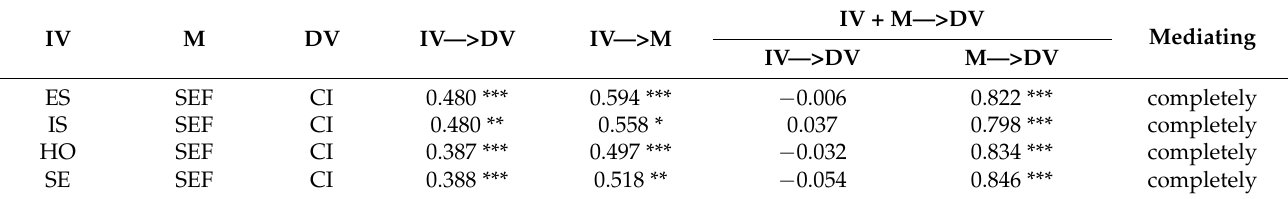
Table 7. Results of the mediation effects